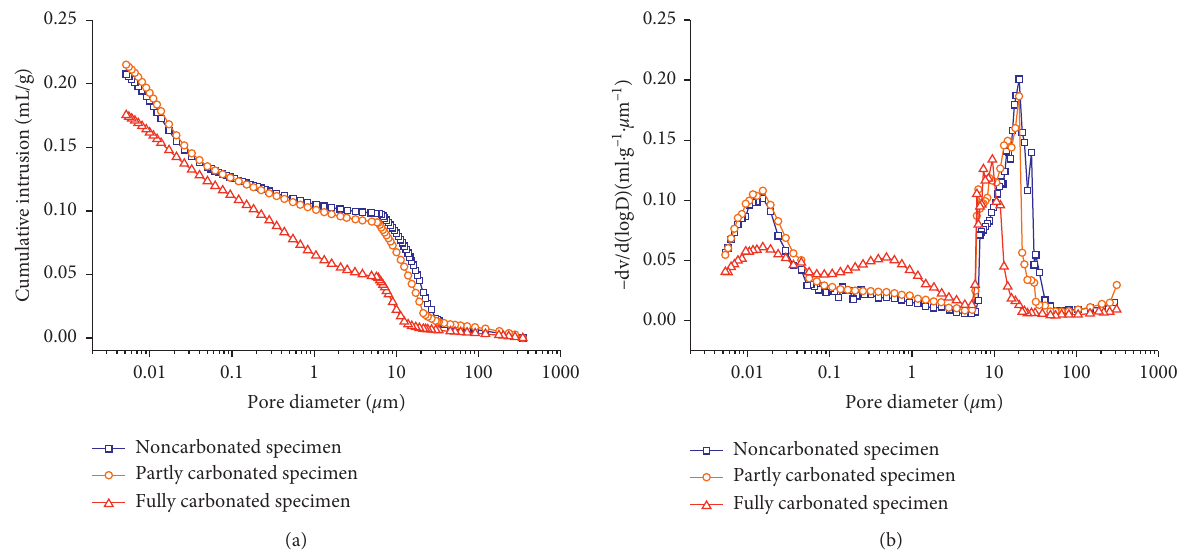
Figure 16: MIP results of different carbonated zones in the specimen. (a) Cumulative intrusion volume. (b) Differential intrusion volume.